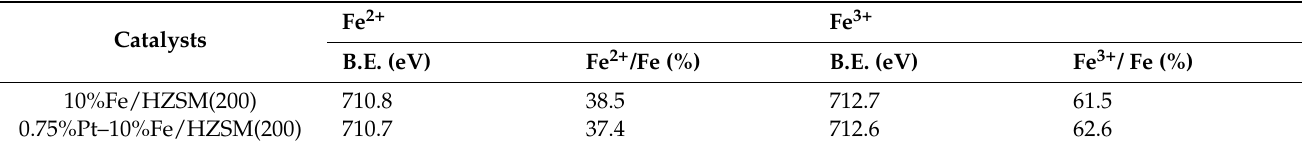
Table 4. Binding energy and proportion of each Fe